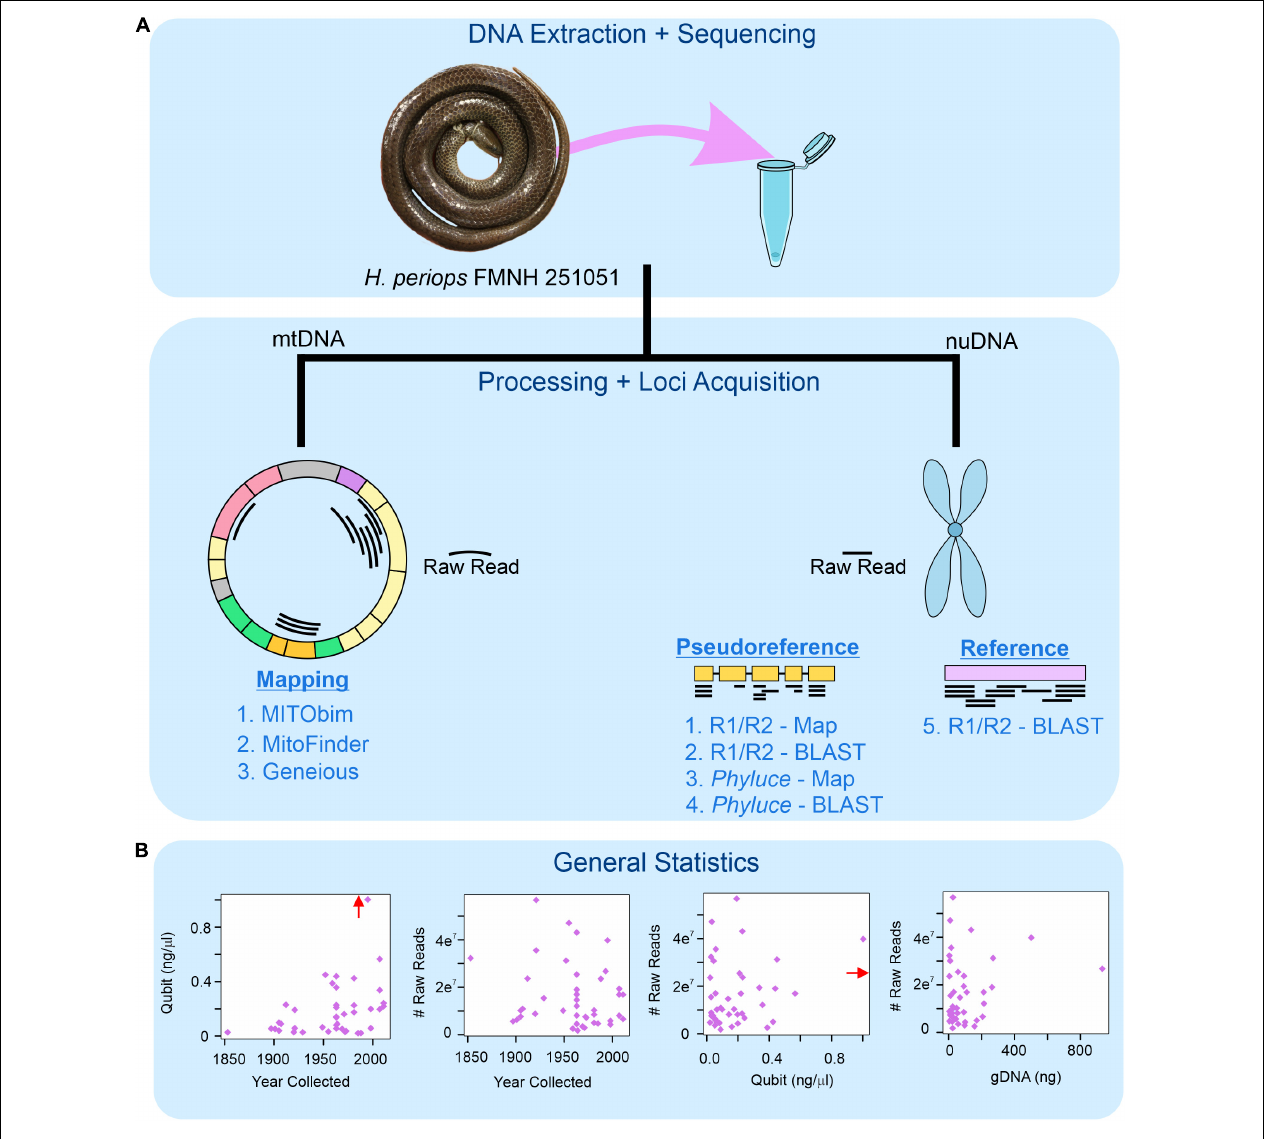
FIGURE 1 | Workflow for museum genomics in this project. (A) Three approaches for mitochondrial mapping to a reference genome (left) and five for nuclear locus acquisition using mapping and BLAST (right). Phyluce = unaligned.fasta file from Phyluce pipeline; R1/R2 = *.R1.fastq.gz and *.R2.fastq.gz files for raw reads. (B) Read statistics for DNA yield (Qubit) and total number of raw reads obtained by age of specimen (year collected), DNA yield, and total genomic DNA used for sequencing (gDNA). Red arrow shows data point for Hydrablabes periops FMNH 251051 (Qubit = ∼ 6.0 ng/ µ l), arrow positioned along axis corresponding to respective X -axis and Y -axis